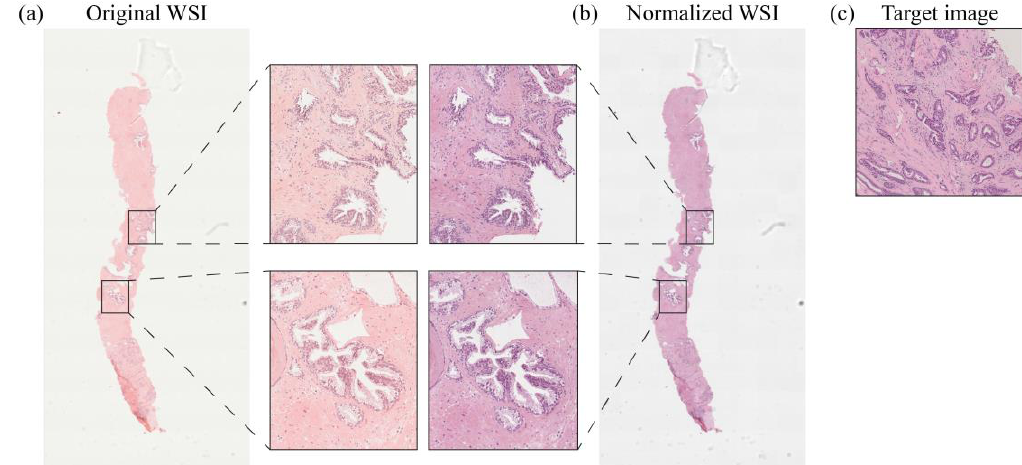
Figure 2. Stain normalization process for a prostate WSI. Original slide ( a ) and normalized slide ( b ) with zoomed-in views showing the effects at high magnification of color normalization with respect to target image ( c ).